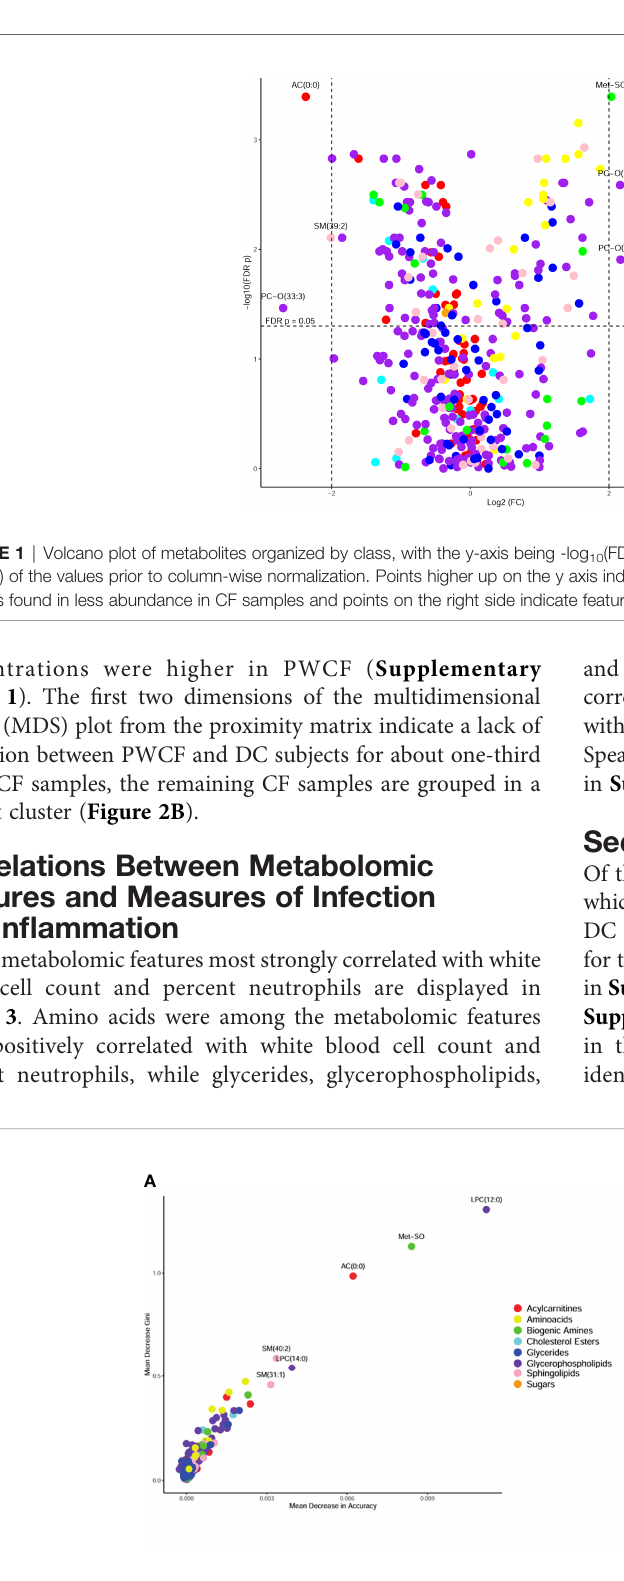
FIGURE 2 | (A) Random forest multiway importance plot showing mean decrease Gini verses mean decrease in accuracy, with important metabolic features identi fi ed by both criteria labeled and point colored by class (B) multidimensional scaling plot of the proximity matrix, red circles corresponding to CF samples, and blue triangles corresponding to disease control samples.